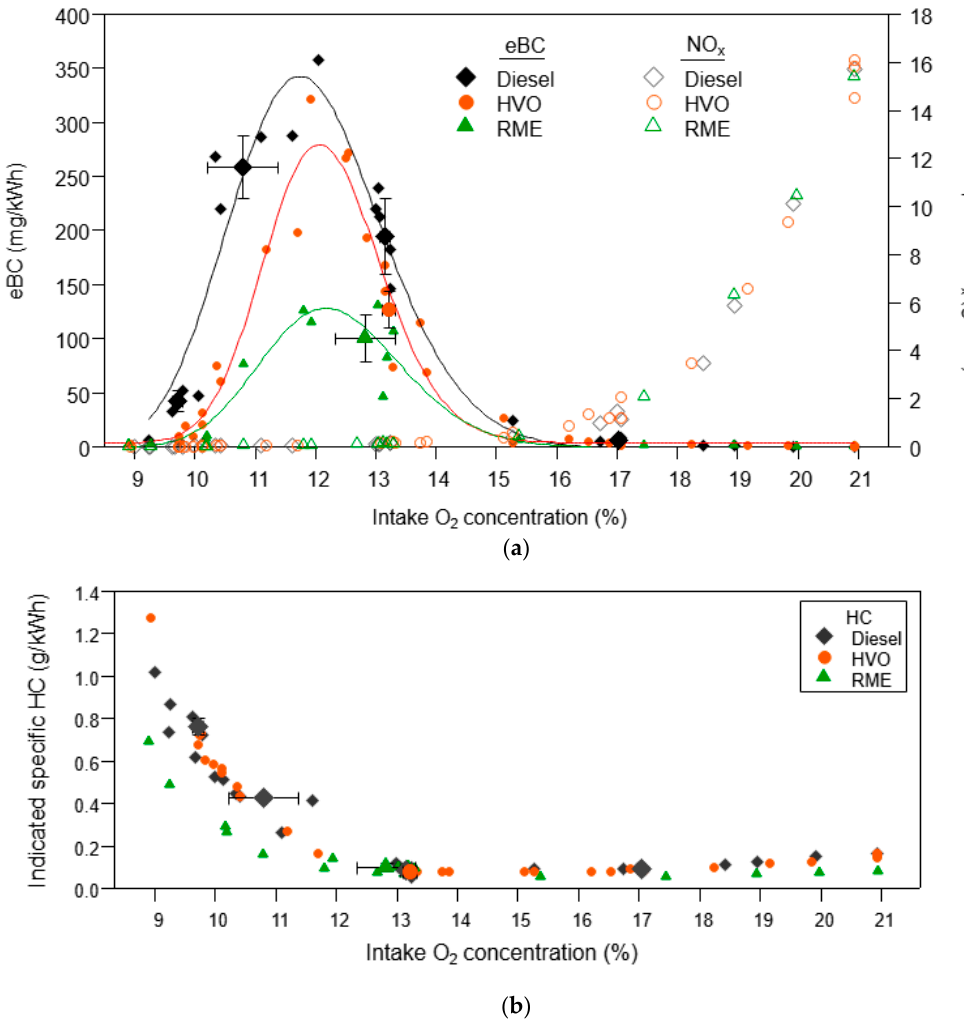
Figure 1. Emission factors (mass/kWh) for equivalent black carbon (eBC), NO x and HC for all fuels, shown as a function of exhaust gas recirculation (EGR). EGR is expressed as intake O 2 concentration. The lines shown in ( a ) are lognormal fits to all eBC data points of respective fuel. Combustion temperature increases with increasing intake O 2 concentrations. The eBC and NO x emission factors as a function of EGR are displayed in ( a ). The emission factors of HC are shown in ( b ) and were well correlated with the emission factors of CO (Figure A2a). The HC–CO correlation is high for all fuels (Figure A2b, R > 0.9). The data in Figure 1 are from EGR sweeps with relatively short averaging time in each point (~1.5 min) and from longer filter collections (replicates). Markers with error bars (±1 std.